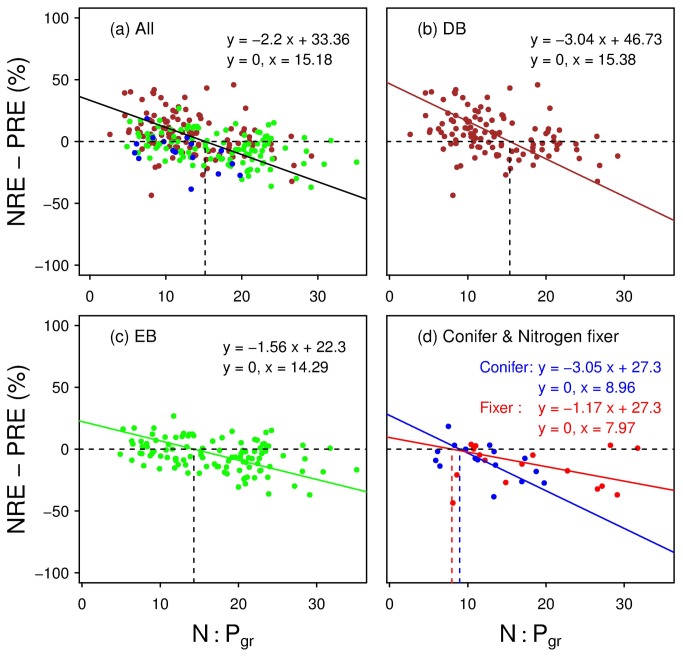
Standardized major axis regression (solid lines) for relative resorption efficiency (NRE - PRE) vs green-leaf N:P ratio for (a) all species, black lines; (b) deciduous broadleaf species (DB), brown dots and lines; (c) evergreen broadleaf (EB), green dots and lines; (d) conifers and N-fixing species, respectively blue and red dots and lines.The horizontal dash lines indicate where NRE equals PRE, and the vertical dash lines display the corresponding N:P ratios.